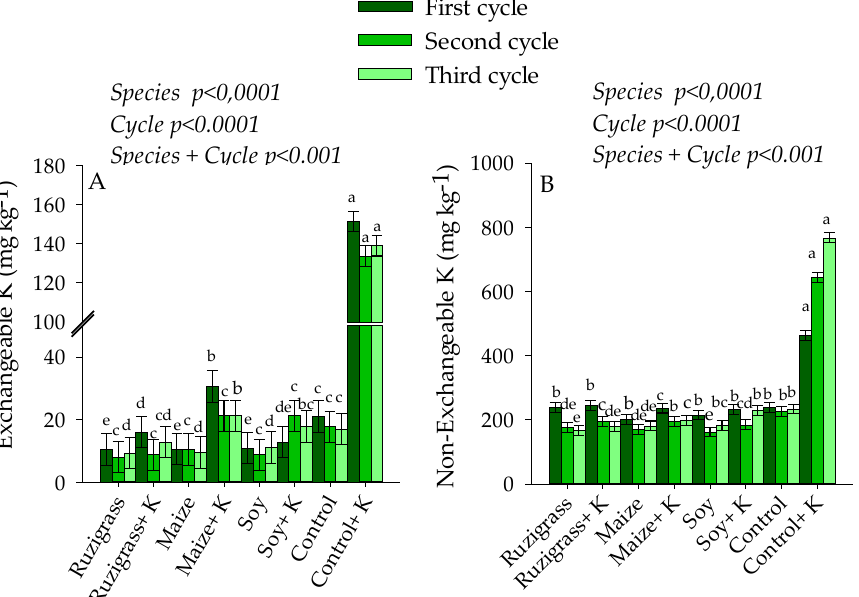
Figure 2. Soil exchangeable K ( A ), and nonexchangeable K ( B ), in three successive ruzigrass, maize, and soybean crop growth cycles with or without application of K fertilizer. The absence of overlap by vertical bars shows significant differences among cycles in the same crop and fertility treatment. Lowercase letters indicate differences among species when crop cycle and fertility treatment were held constant (LSD, p ≤ 0.05).